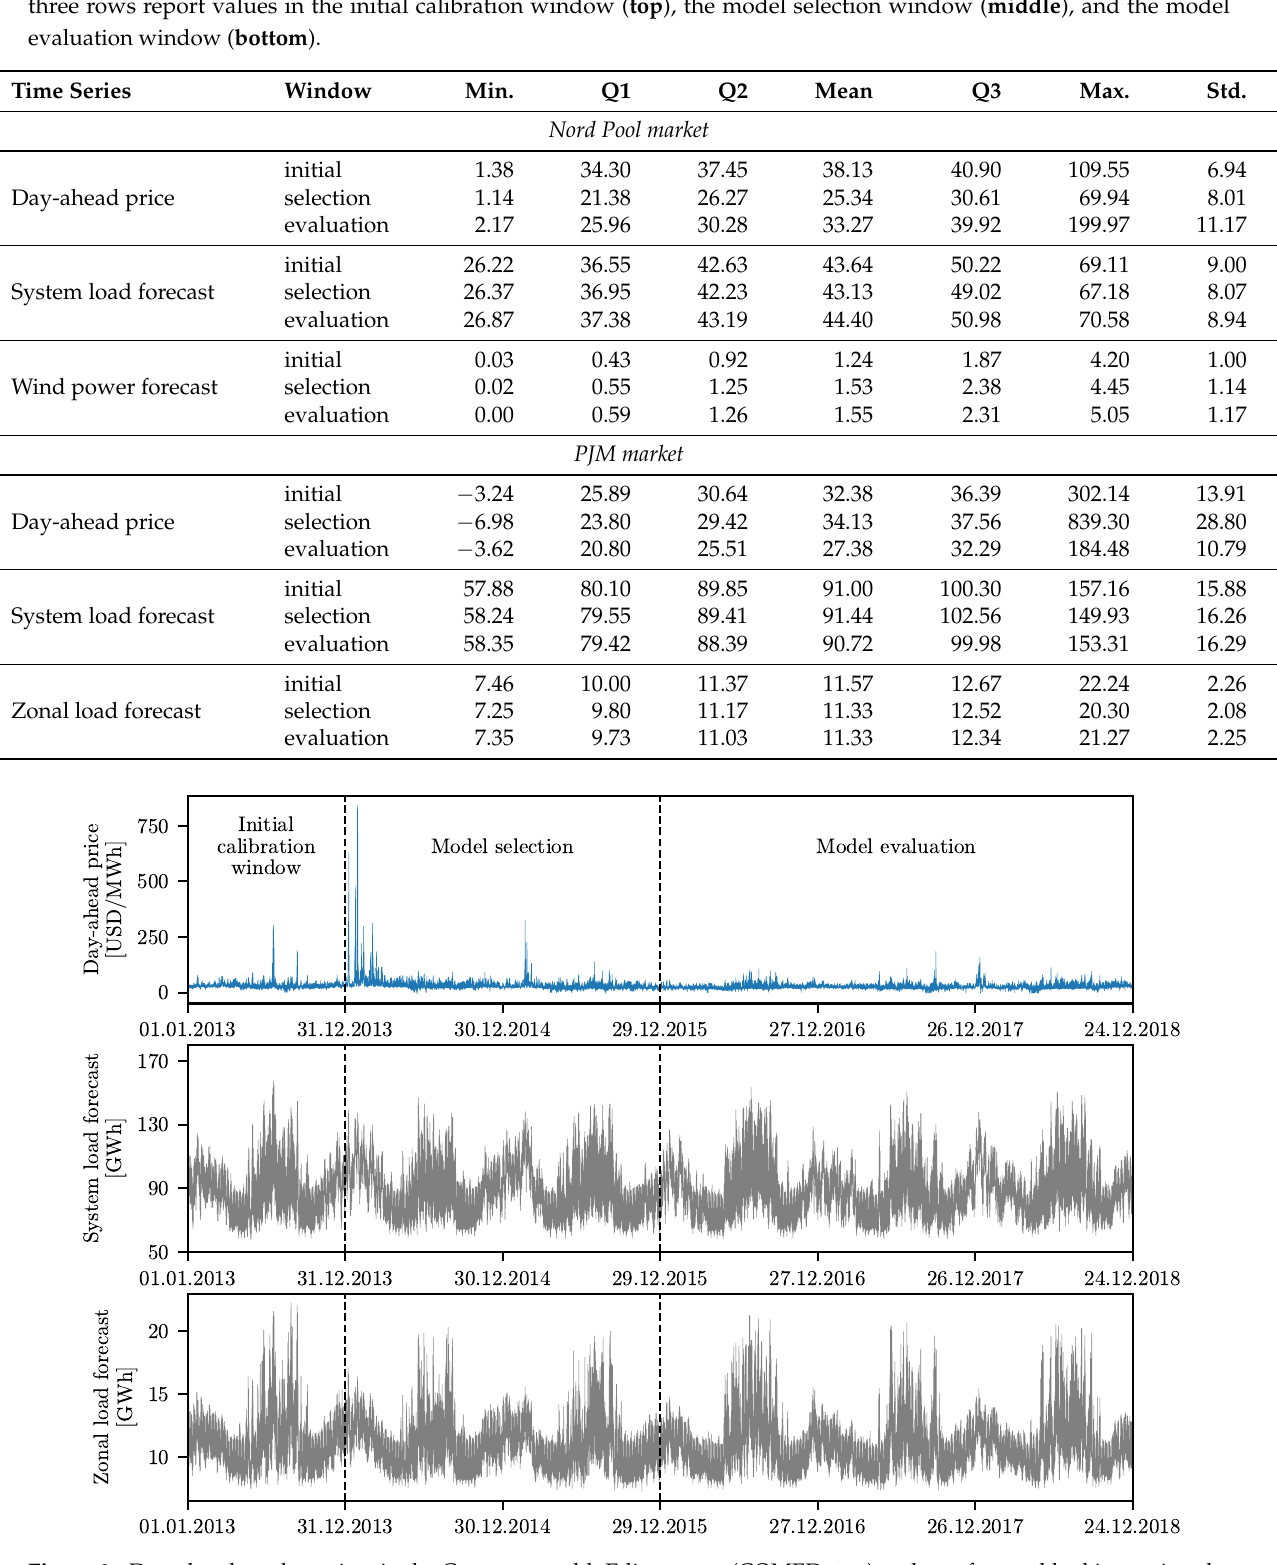
Figure 2. Day-ahead market prices in the Commonwealth Edison zone (COMED; top ) and two forward looking series: the day-ahead system ( middle ) and COMED zone ( bottom ) load forecasts. The vertical dashed lines indicate the beginnings of the model selection (31 December 2013) and model evaluation (29 December 2015)